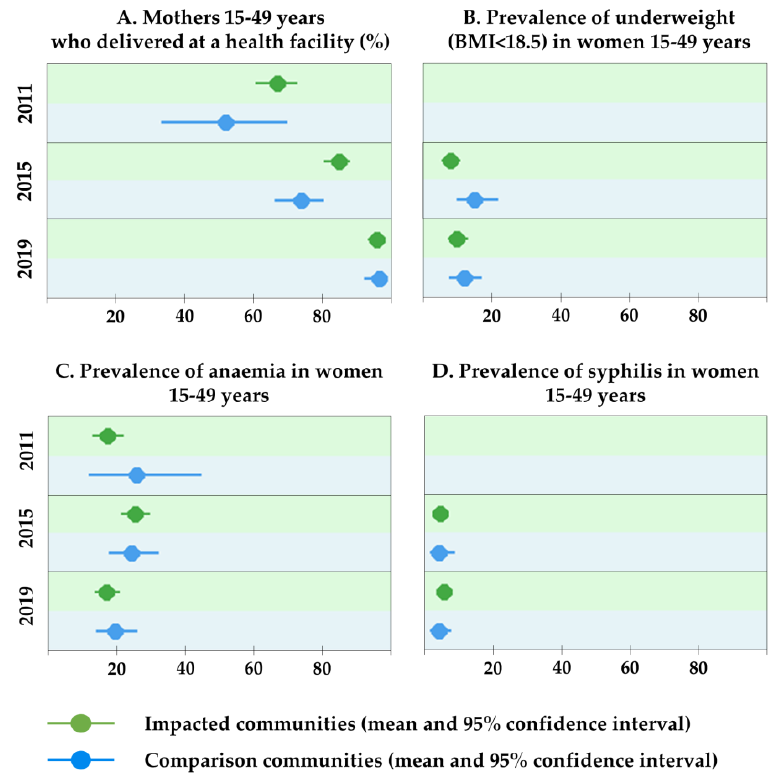
Figure 5. Women’s health indicators, Trident project, Zambia (2011, 2015 and 2019).